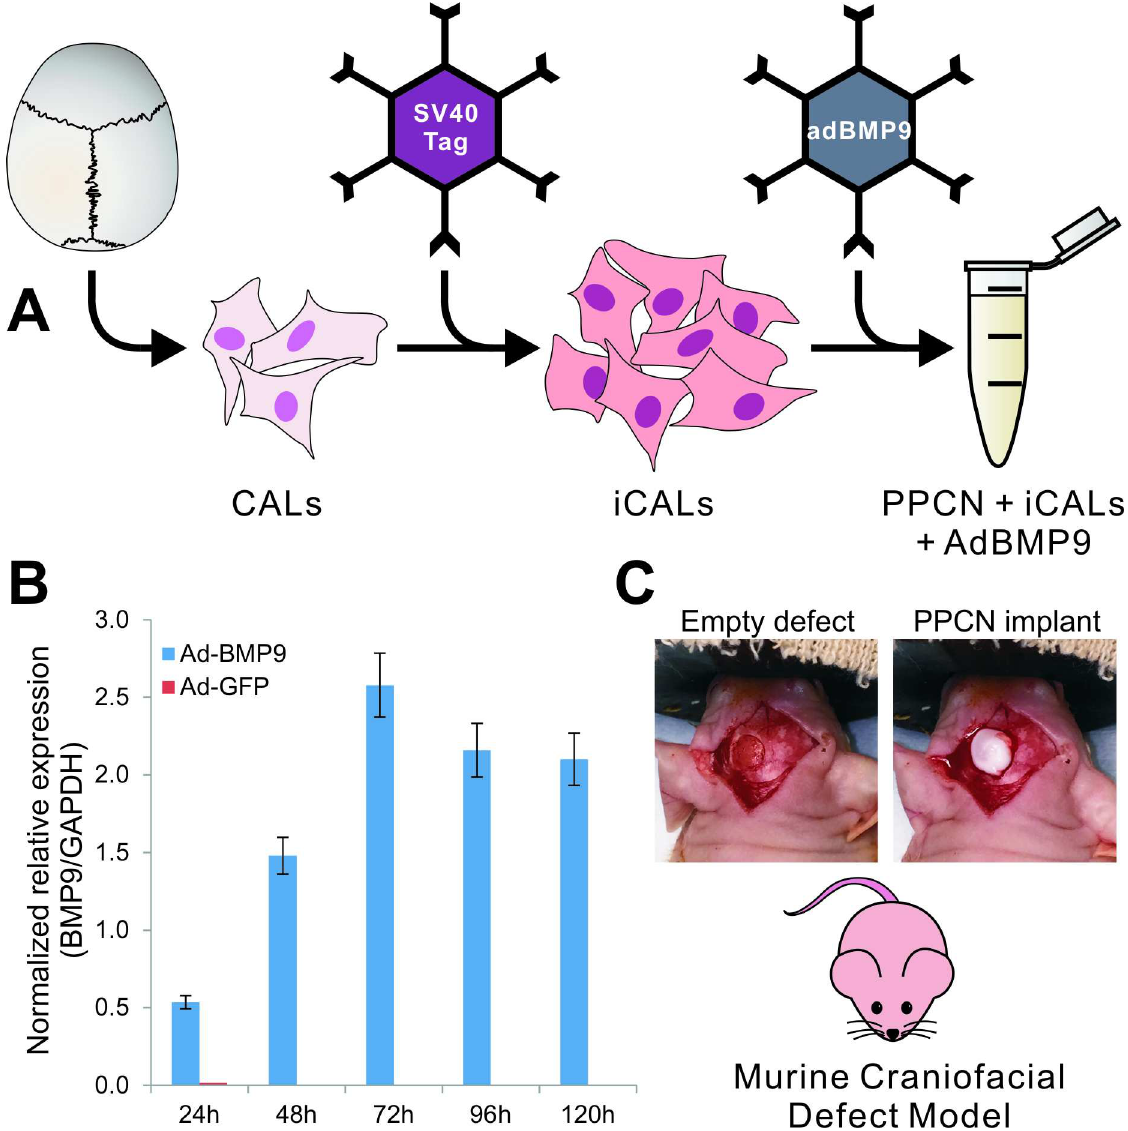
Fig 1. Schematic representation of the overall experimental design. (A) Murinecalvarialcells (CALs) were immortalized via retrovirallyintroducedSV40 large T antigento produceiCALs. iCALs were then transduced with BMP9 via adenoviral vector and mixed with PPCN scaffoldingmaterial. (B) qPCR analysisdemonstrating relative expressionof BMP9 in iCALs infected with ad- BMP9 (blue bars) comparedto control (ad-GFP)-infected cells (red bars). Gene transcript expression was normalized against GAPDH expression. (C) The mixture was subsequently tested in our murine craniofacial defect model. Four millimeter diameter full-thickness calvarialdefects were created in the left parietalbone of 8-week-old male athymic (nu/nu) mice. The newly created empty defect reveals the underlying dura mater. PPCN alone or PPCN and adenovirally transduced immortalized calvarialcells were used to fill the defect